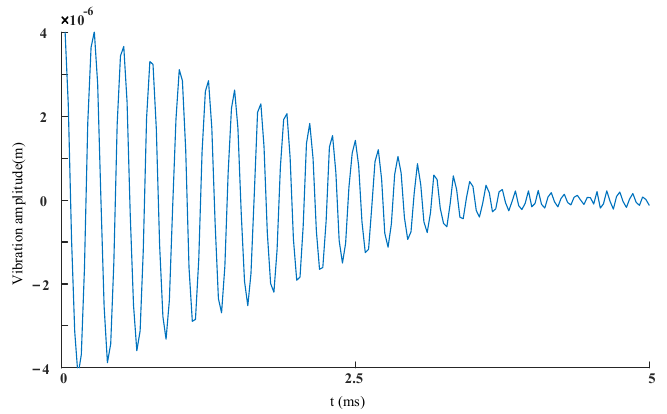
Figure 6. Impact response of the tip of Tool A.